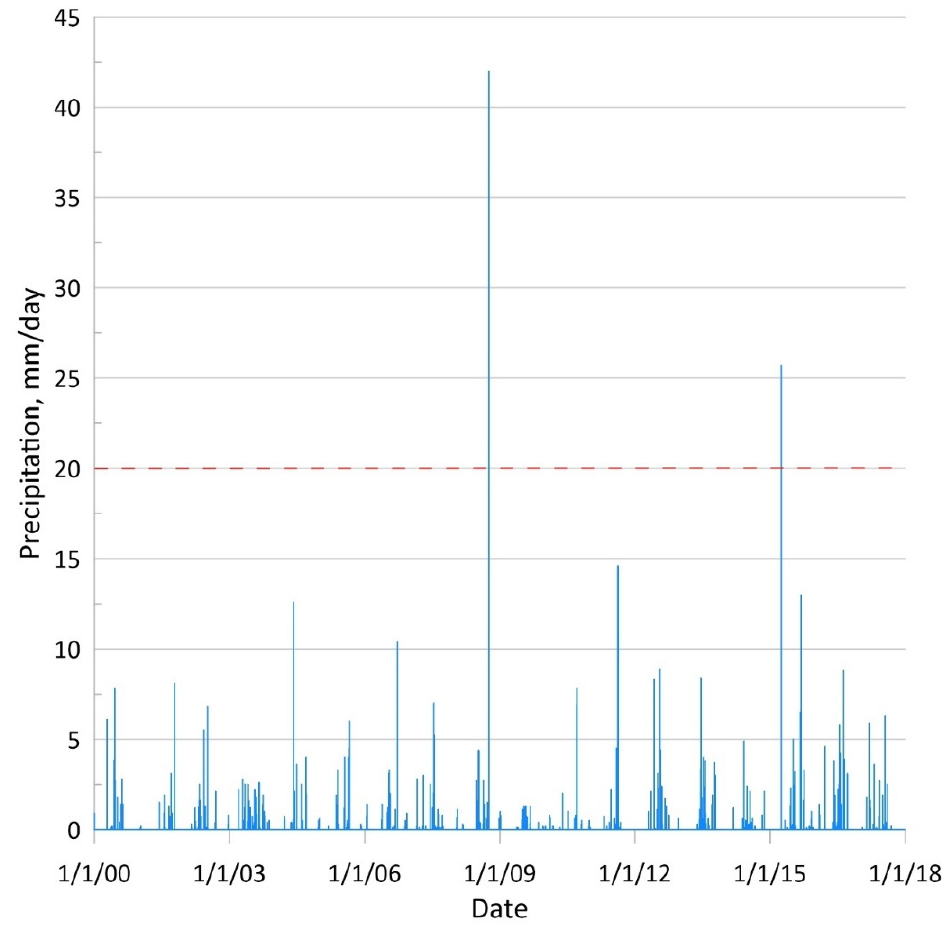
Figure 5. Daily precipitation for the period 2000–2017 recorded at the Ejina weather station. The dashed line represents the minimum precipitation able to form recharge according to Sun et al. [30].